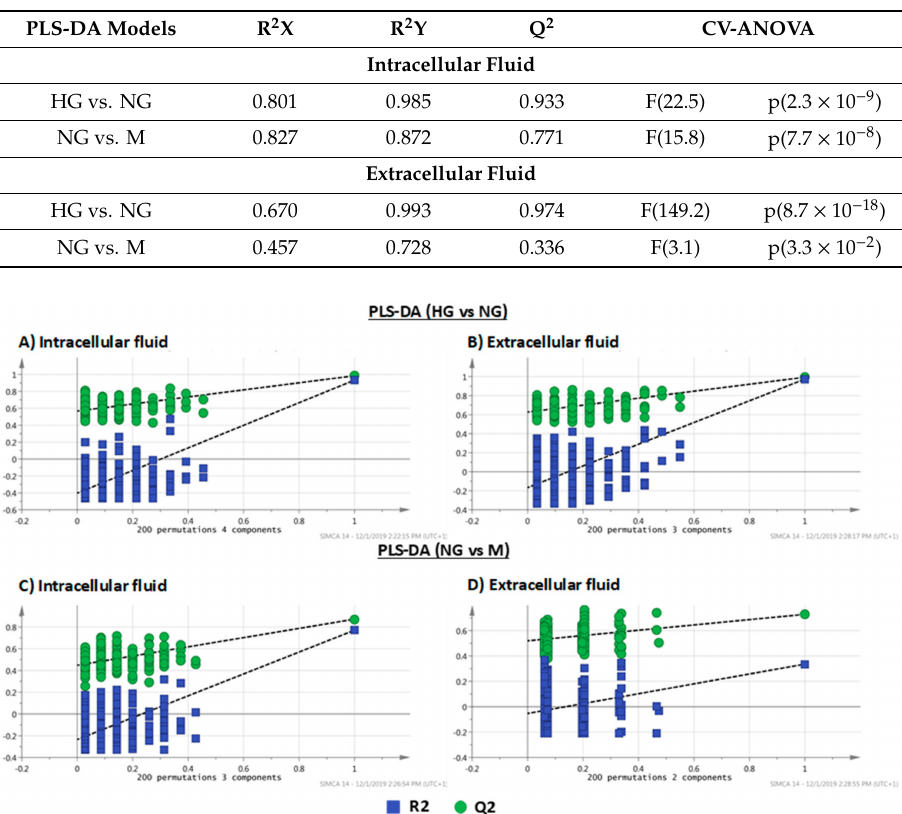
Figure 2. Permutation tests of PLS-DA models of both intracellular and extracellular fluids: ( A ) intracellular fluid (HG vs. NG), ( B ) extracellular fluid (HG vs. NG), ( C ) intracellular fluid (NG vs. M), ( D ) extracellular fluid (NG vs.